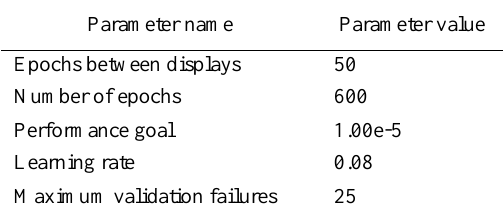
Table 1. Neural Network